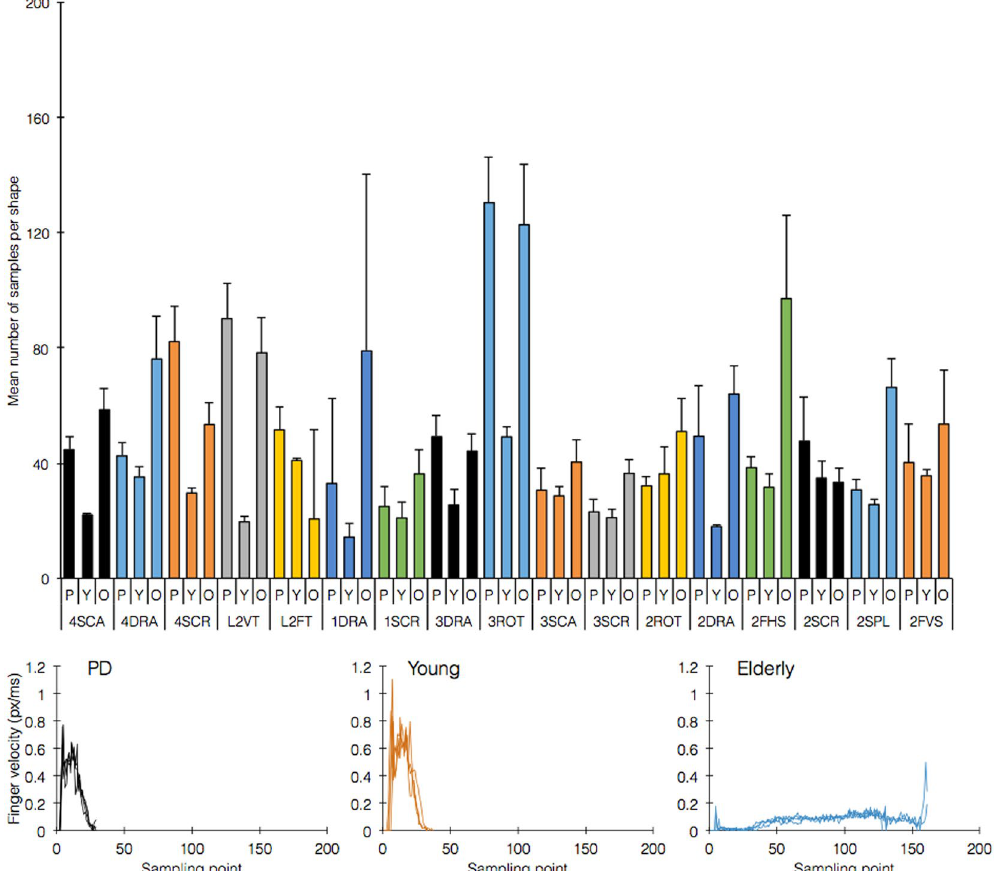
Figure 3. Similarity distribution between PD, young, and elderly subjects according to shape. The figure reports the mean count of data points per shape. Shape acronyms: 1SCR = one finger scroll, 4SCA = four finger scale, 2SCR = two finger scroll, 3SCA = three finger scale, 4SCR = four finger scroll, 1DRA = one finger drag, 2FHS = two finger horizontal scale, 2DRA = two finger drag, 2FVS = two finger vertical scale, 3SCR = three finger scroll, 3ROT = three finger rotate, L2VT = lock 2 and one finger vertical tilt, 2ROT = two finger rotate [two hand], 4DRA = four finger drag, 3DRA = three finger drag, 2SPL = two finger split, L2FT = lock 2 and one finger horizontal tilt (shown here are 17/18 shapes; two finger rotate [one hand] is on a different scale). Bottom panels show overlaid finger traces from a representative shape, showing PD-Y